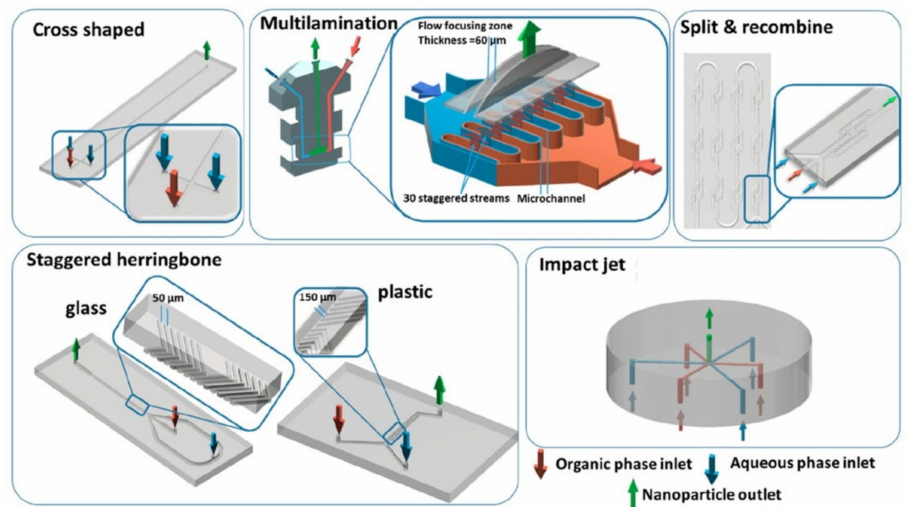
Figure 6. Overview of microfluidic mixers used for nanoparticle preparation. (Adapted with permis- sion from [132]. Copyright 2022 American Chemical